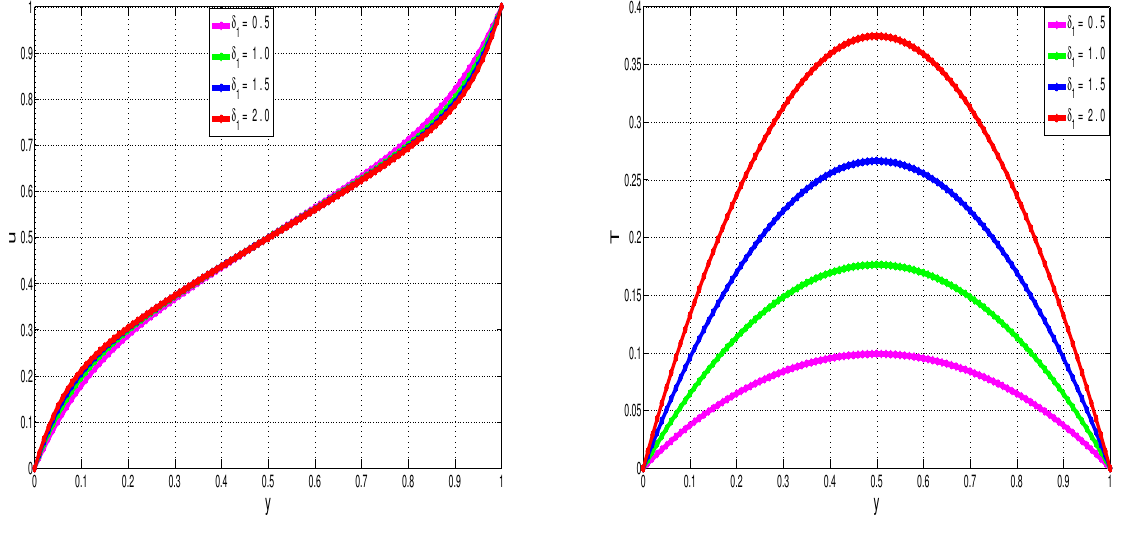
Figure 13. Variation of velocity profiles ( left ) and temperature profiles ( right ) with δ 1 where β = 0.95, ε = 2.